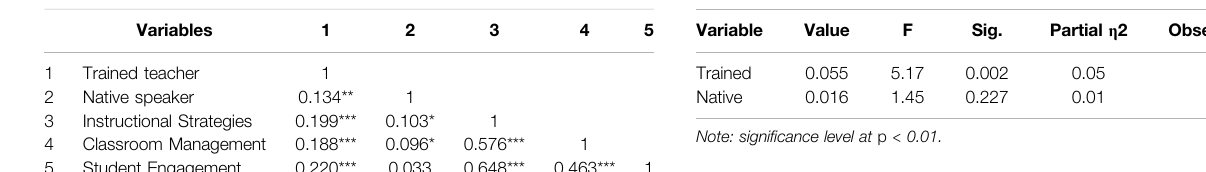
TABLE 3 | Correlation between variables.